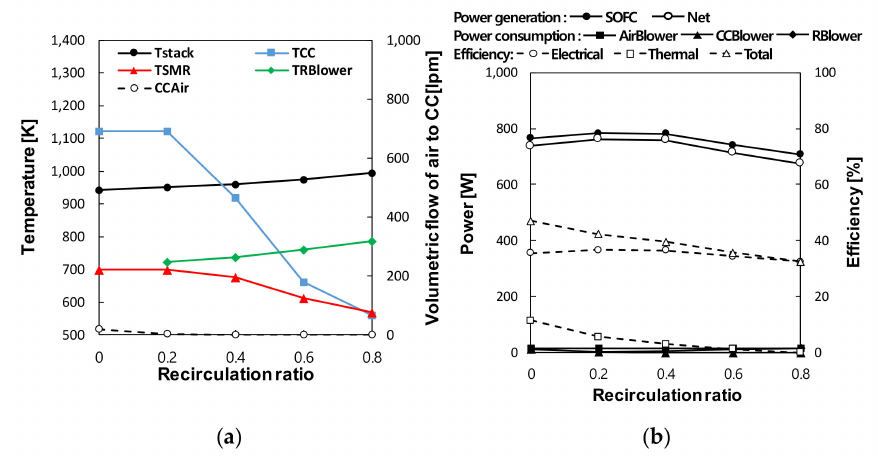
Figure 9. The effect of recirculation ratio on the AOGR #1 system; ( a ) temperature of each component and ( b ) power and efficiency.